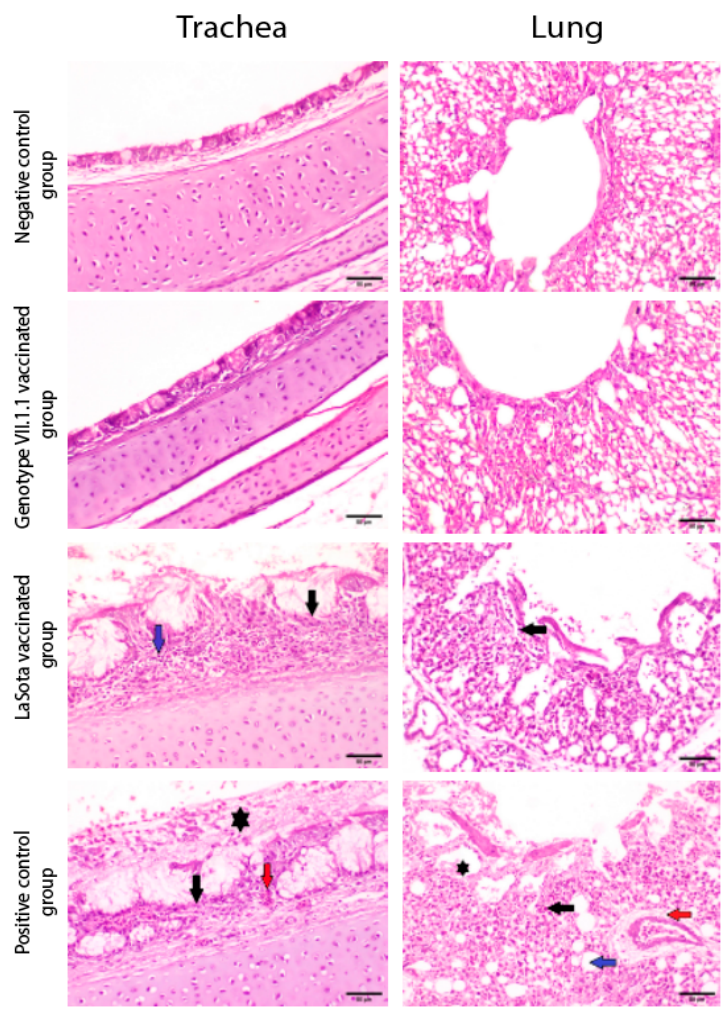
Figure 7. Photomicrographs representing H&E stained sections of tracheas and lungs collected from genotype VII.1.1 and LaSota vaccinated- challenged chicks with virulent NDV compared to mock chicks (negative control) and positive control groups (non-vaccinated challenged chicks). Non-vaccinated- non-challenged chicks and genotype VII.1.1 vaccinated- challenged chicks showing normal histological architecture for Tracheas and normal histological architecture of parabronchus and air capillaries in lungs. On the other hand, LaSota vaccinated challenged chicks showed necrosis of lamina epithelialis and mucosal glands (black arrow) associated with mononuclear cells infiltration in lamina propria (blue arrow) in Trachea and inflammatory cells infiltration (black arrow) in lungs. In addition, non-vaccinated-challenged chicks (positive control group) showing multifocal necrosis of lamina epithelialis (black arrow), congestion (red arrow) and accumulation of mucous exudate in the tracheal lumen (asterisk) in Trachea and showing inflammatory cells infiltration in the air capillaries (black arrow), perivascular edema (red arrow), dilatation of atria (asterisk) and dilatation of air capillaries (blue arrow) in lungs (scale bar 50 μ m).